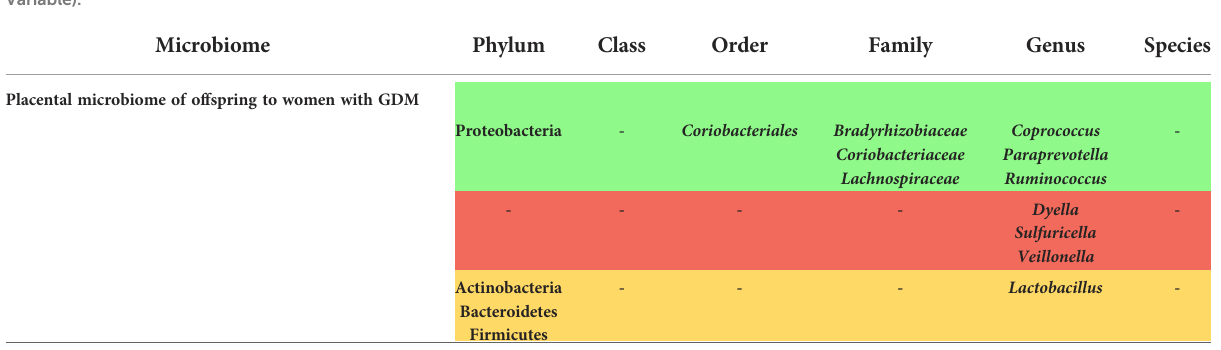
TABLE 6 Summary of the placental microbiome alterations in offspring to patients with GDM ( = Increased, = Decreased, = Variable).